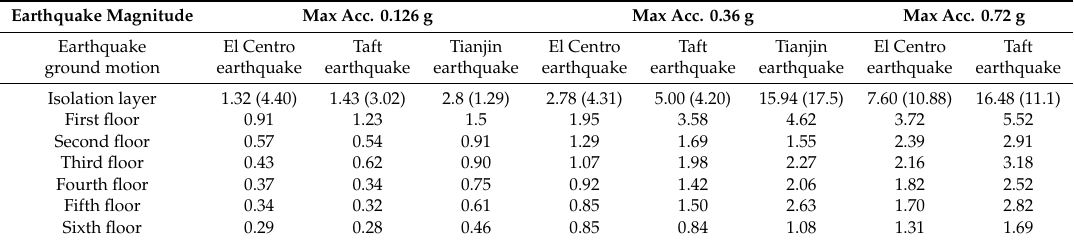
Table 2. The peak interlayer drift under di ff erent seismic inputs in switch control (mm). Earthquake Magnitude Max Acc. 0.126 g Earthquake El Centro ground motion earthquake Isolation